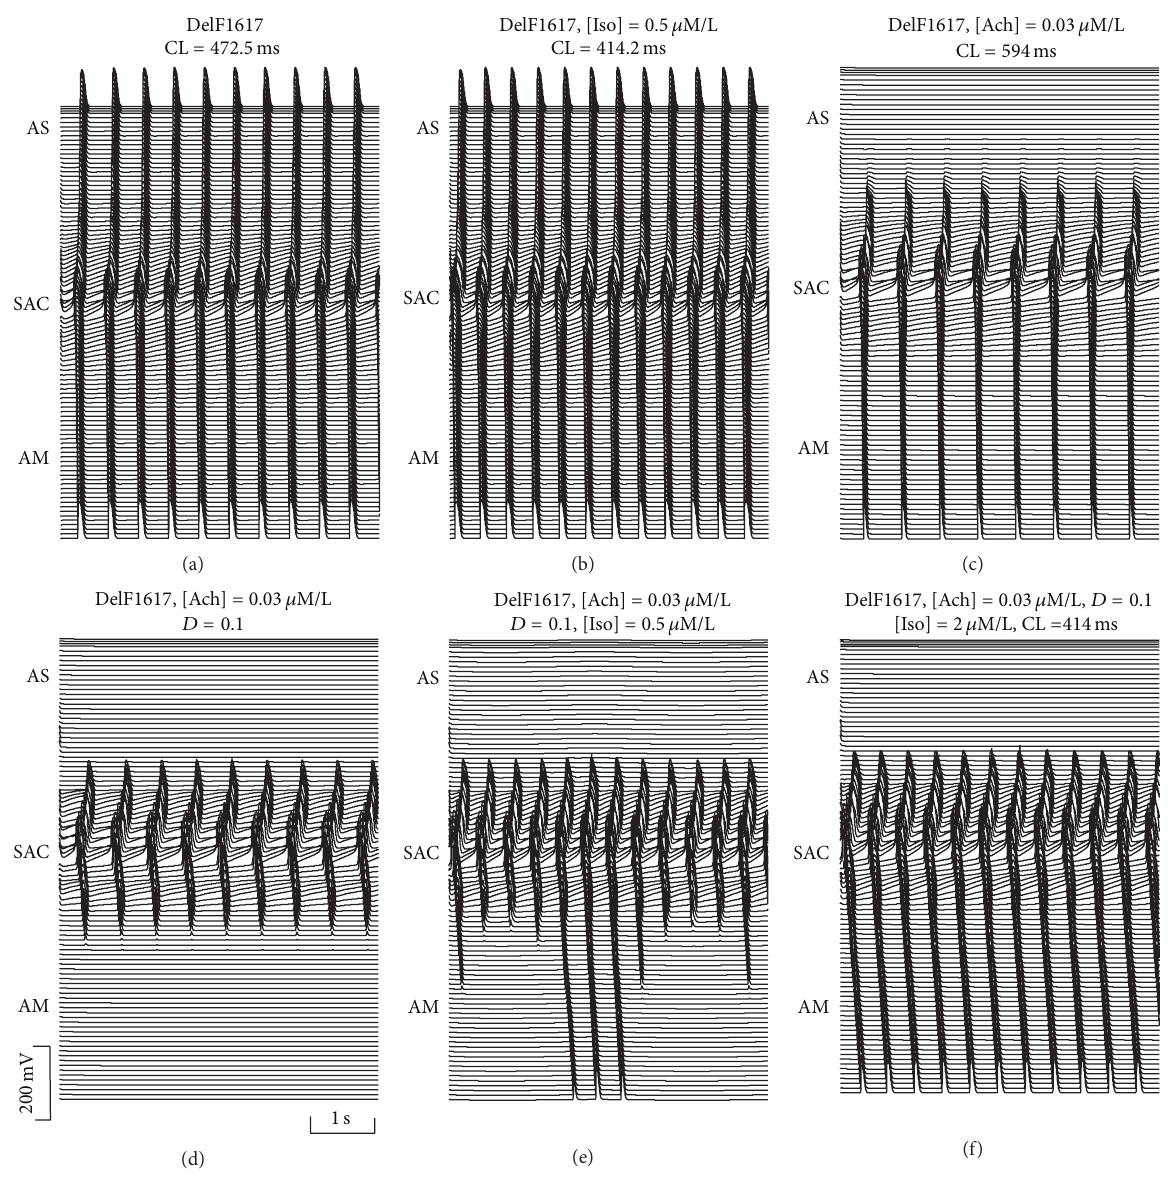
Figure 4: Effects of Iso on action potential conduction. Action potential profiles in the 2D tissue with the DelF1617 mutant channel under different conditions are shown. (a) Mutant channel alone; (b) [Iso] = 0.5 𝜇 M/L; (c) [Ach] = 0.03 𝜇 M/L; (d) [Ach] = 0.03 𝜇 M/L and 𝐷 = 0.1 ; (e) [Ach] = 0.03 𝜇 M/L, 𝐷 = 0.1 , and [Iso] = 0.5 𝜇 M/L; (f) [Ach] = 0.03 𝜇 M/L, 𝐷 = 0.1 , and [Iso] = 2.0 𝜇